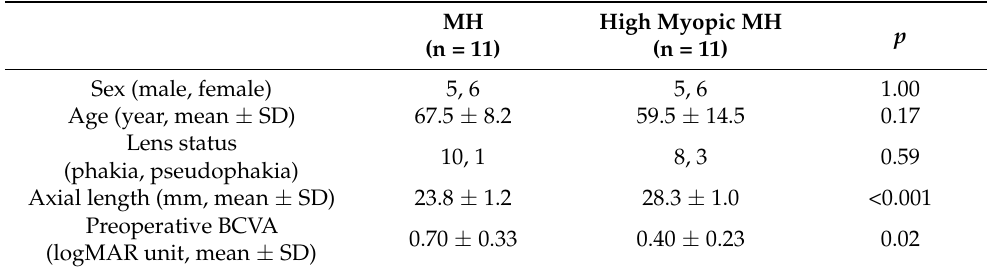
Table 1. Characteristics and clinical findings. MH: macular hole; BCVA: best corrected visual acuity; LogMAR: logarithm of the minimum angle of resolution.